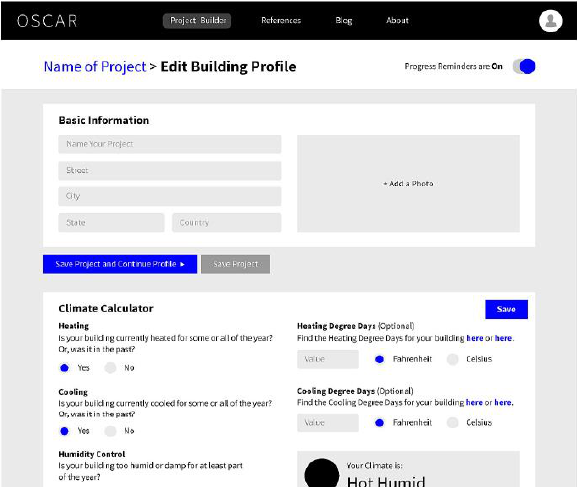
Figure 6. Building Profile wireframe (preliminary) mock-up